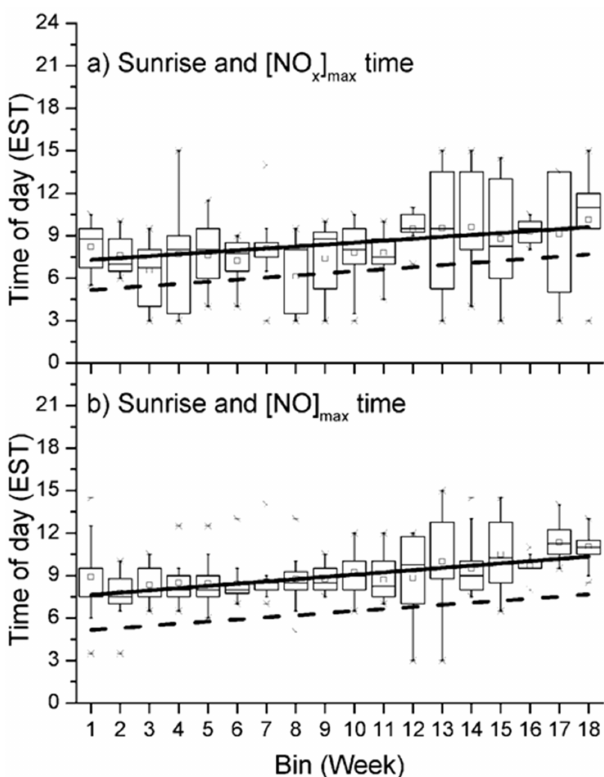
Fig. 6. The relationship between sunrise and time of observed (a) NO x and (b) NO maxima from 03:00 to 15:00 EST from each sampling inlets. The dashed lines denote the change in sun- rise over 18 weeks (five months) in 2008 at UMBS (regression: y = 0 . 147 x + 5 . 01 , r 2 = 0 . 999 ). Data for 7 days, staring on 19 July were binned together and are displayed as box-and-whisker plots that depict the mean, median, 25 and 75 percentile, and 5 and 95 percentile values. The solid regression lines were fit to the weekly median data. They denote the average change in when the NO x and the NO maxima were observed [regression: (a) y = 0 . 135( SE ± 0 . 0355) x +7 . 14( SE ± 0 . 384) , r 2 = 0 . 478 and (b) y = 0 . 159( SE ± 0 . 0321) x + 7 . 46( SE ± 0 . 348) , r 2 = 0 . 605 ].